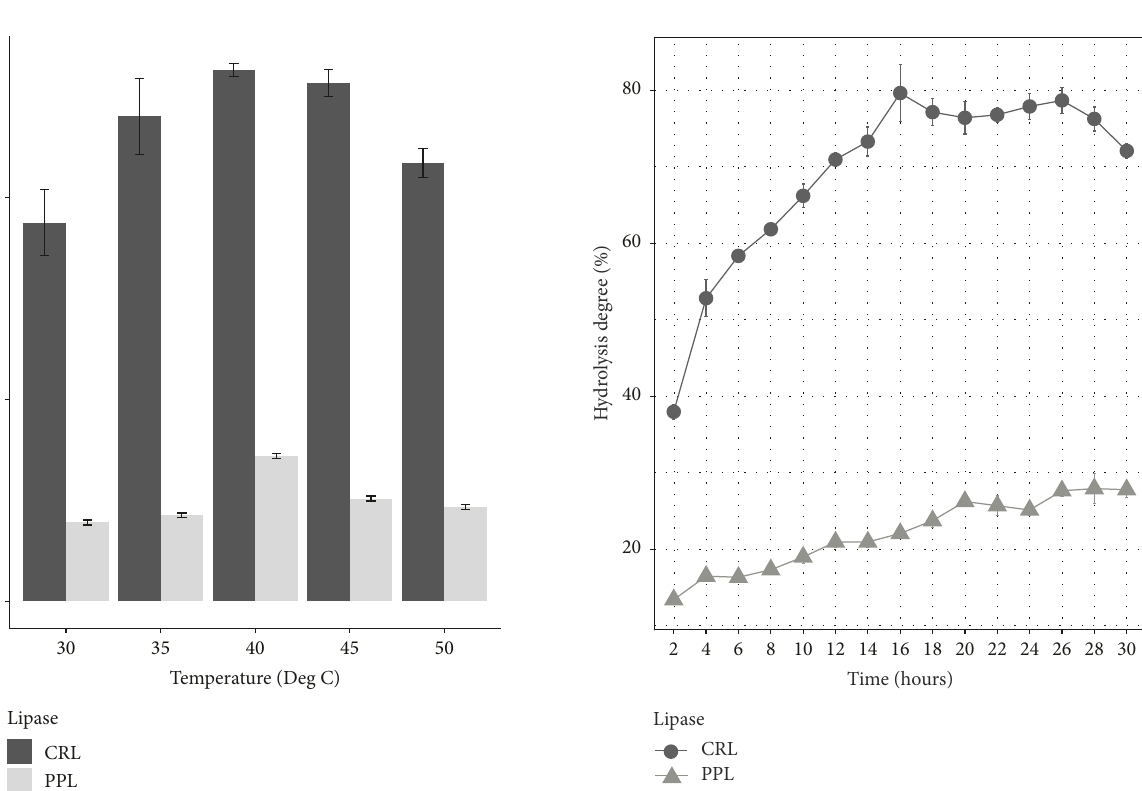
Figure 4: Effect of temperature on hydrolysis degree of two lipase types.